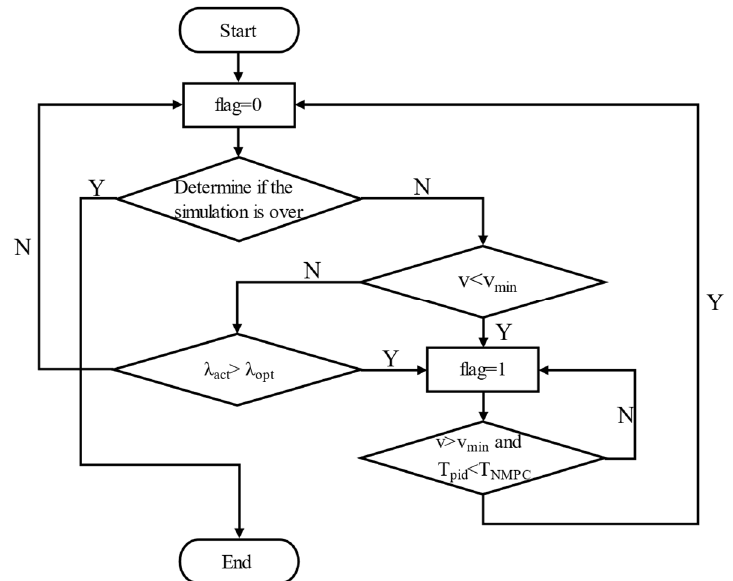
Figure 5. The process of the torque